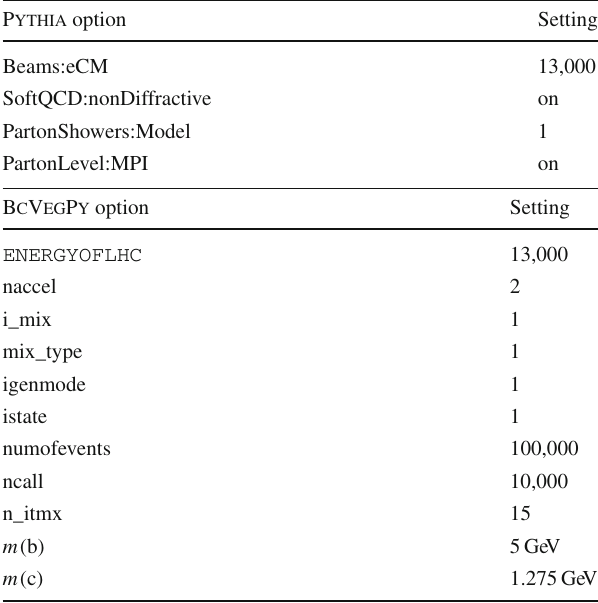
Table 3 Pythia and BcVegPy generation settings used to simulate the samples of B + c mesons. The specific meanings of the parameters can be found in the relevant documentation [12,13]. Additionally, in Pythia all ground-state heavy hadrons are treated as stable. As such,